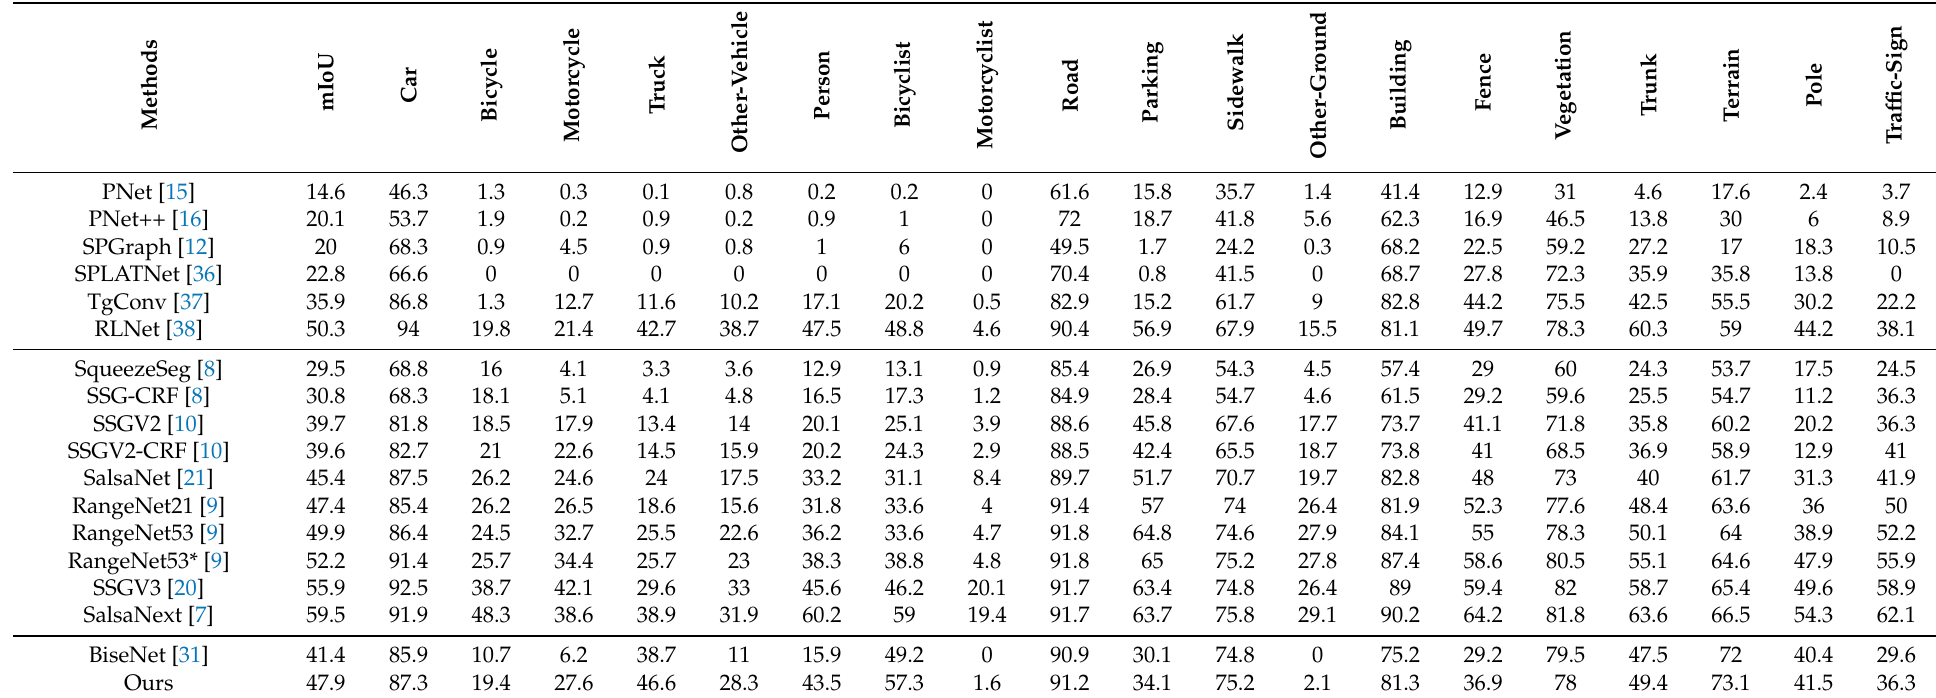
Table 1. Segmentation mIoU (%) results on the Semantic-KITTI test